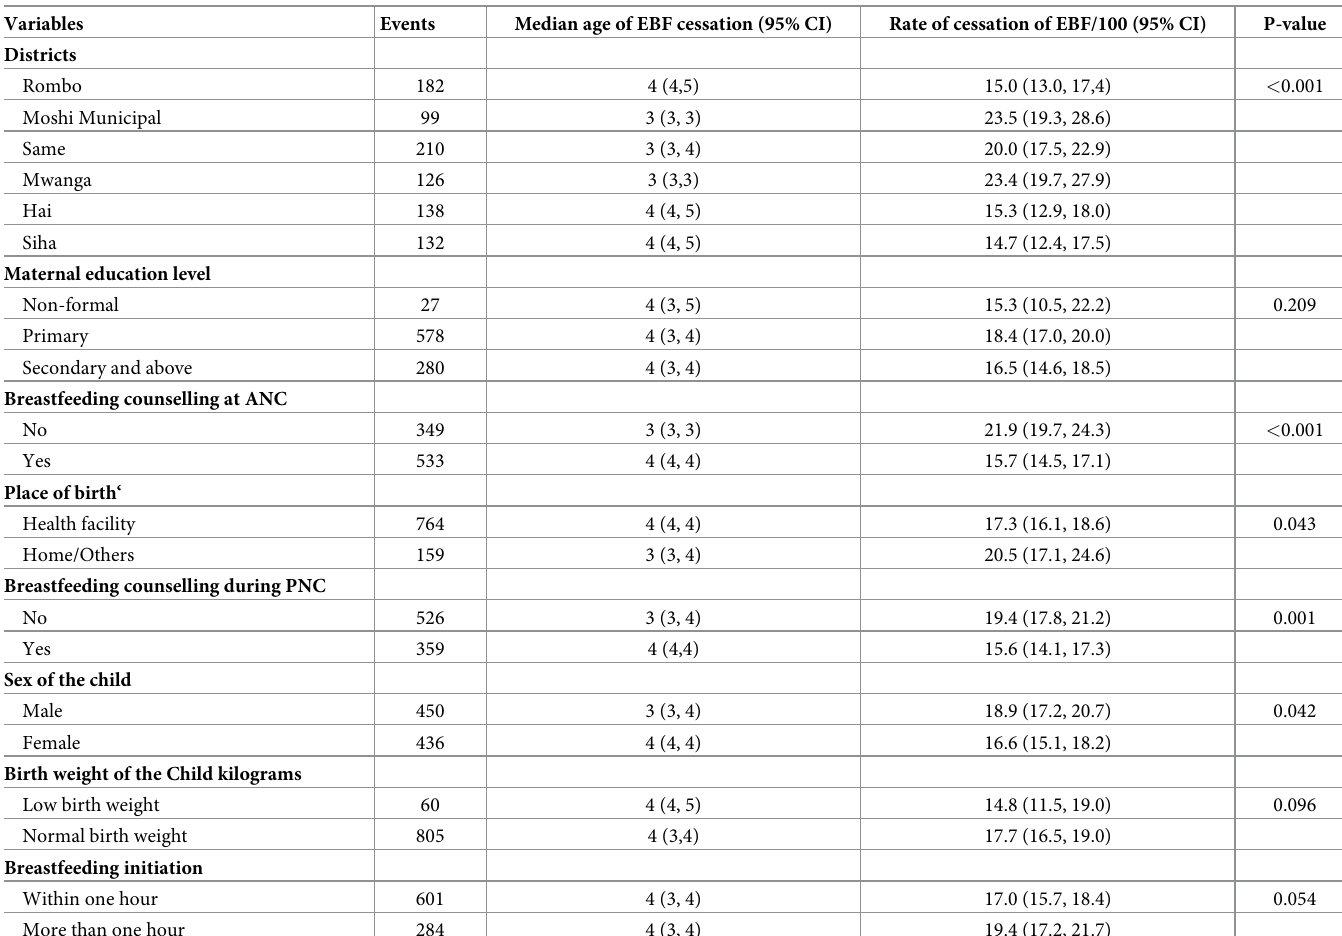
Table 4. Rate of cessation of EBF by background characteristics (N =